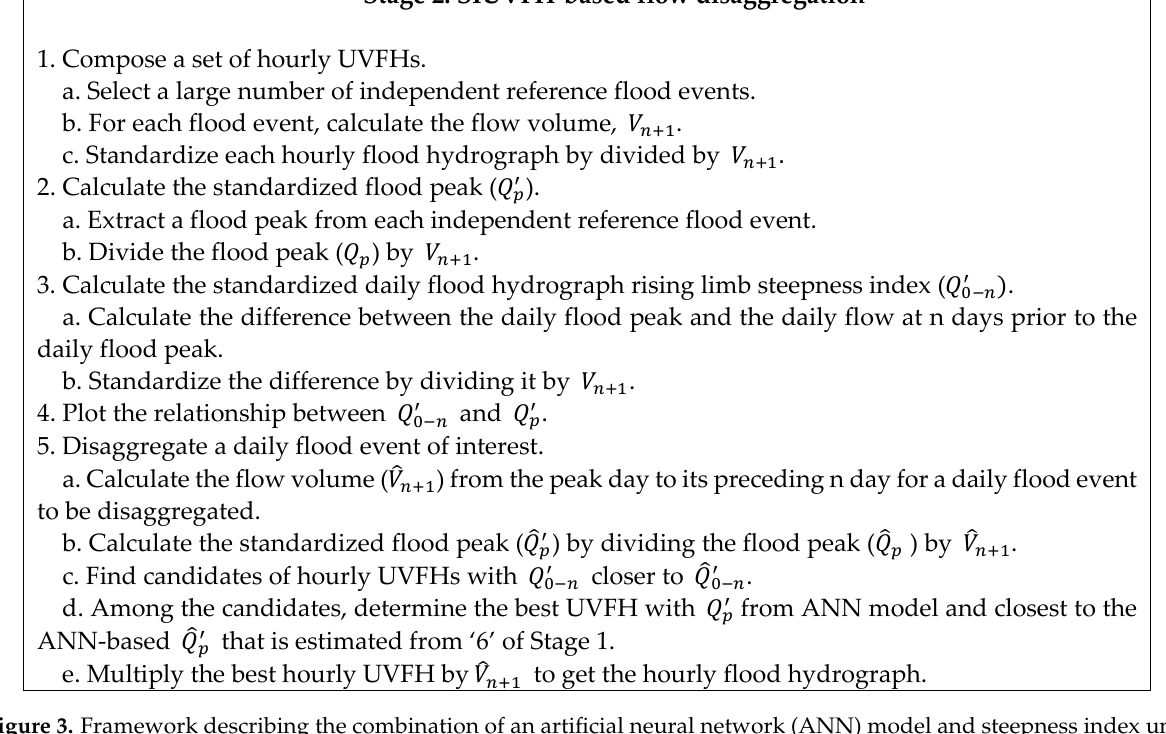
Figure 3. Framework describing the combination of an artificial neural network (ANN) model and steepness index unit volume flood hydrograph (SIUVFH) method.